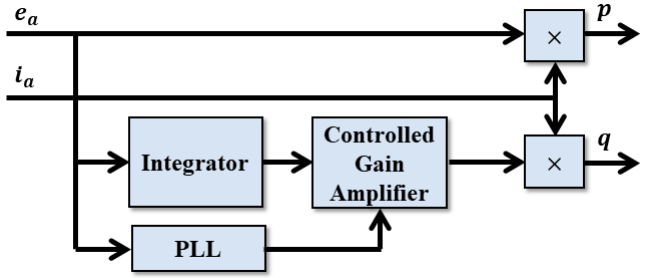
Figure 3. Power calculation by integration method.